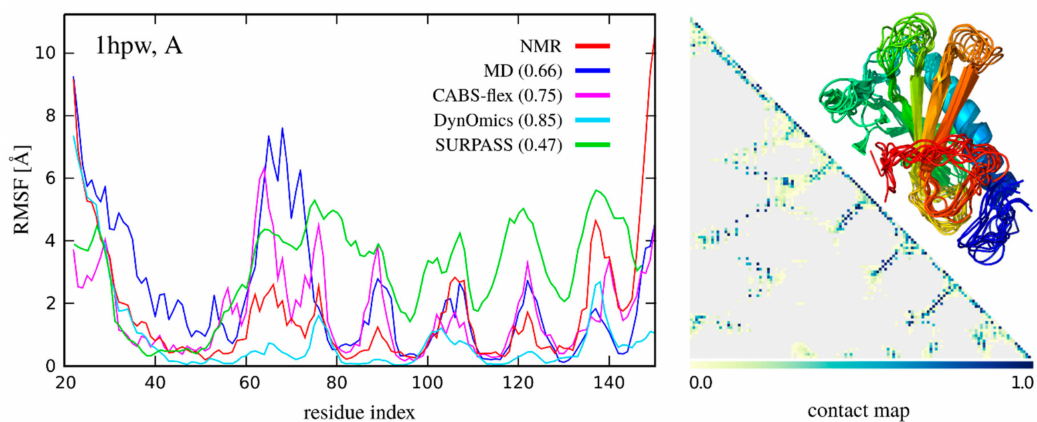
Figure 7. Comparison of residue fluctuation (root mean square fluctuation (RMSF)) profiles for an example protein (PDB code: 1hpw, chain A). Chart on the left presents RMSF values (in Å) derived from NMR ensembles (red) and simulation trajectories: all-atom MD (blue), CABS-flex (pink), DynOmics (light blue), and SURPASS (green). In the legend, the values in brackets show Spearman’s correlation coefficients for residue fluctuations between NMR and each method. The chart on the right presents a contact map (frequency of contacts is showed in different colors, see the color scale) and example fluctuation profiles visualized on the structures given by the CABS-flex 2.0 server